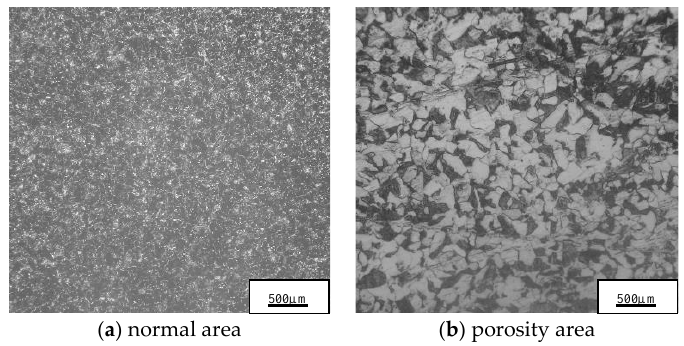
Figure 6. Low magnification microstructure of ( a ) normal area and ( b ) defective area.